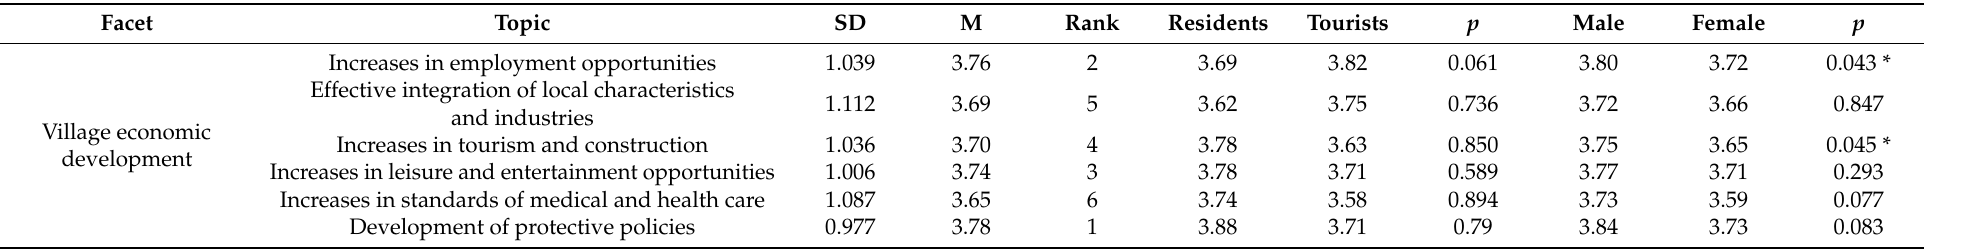
Table 3. Analysis of perceptions of village economic, social, environmental, ecological, and environmental development. Facet Topic SD M